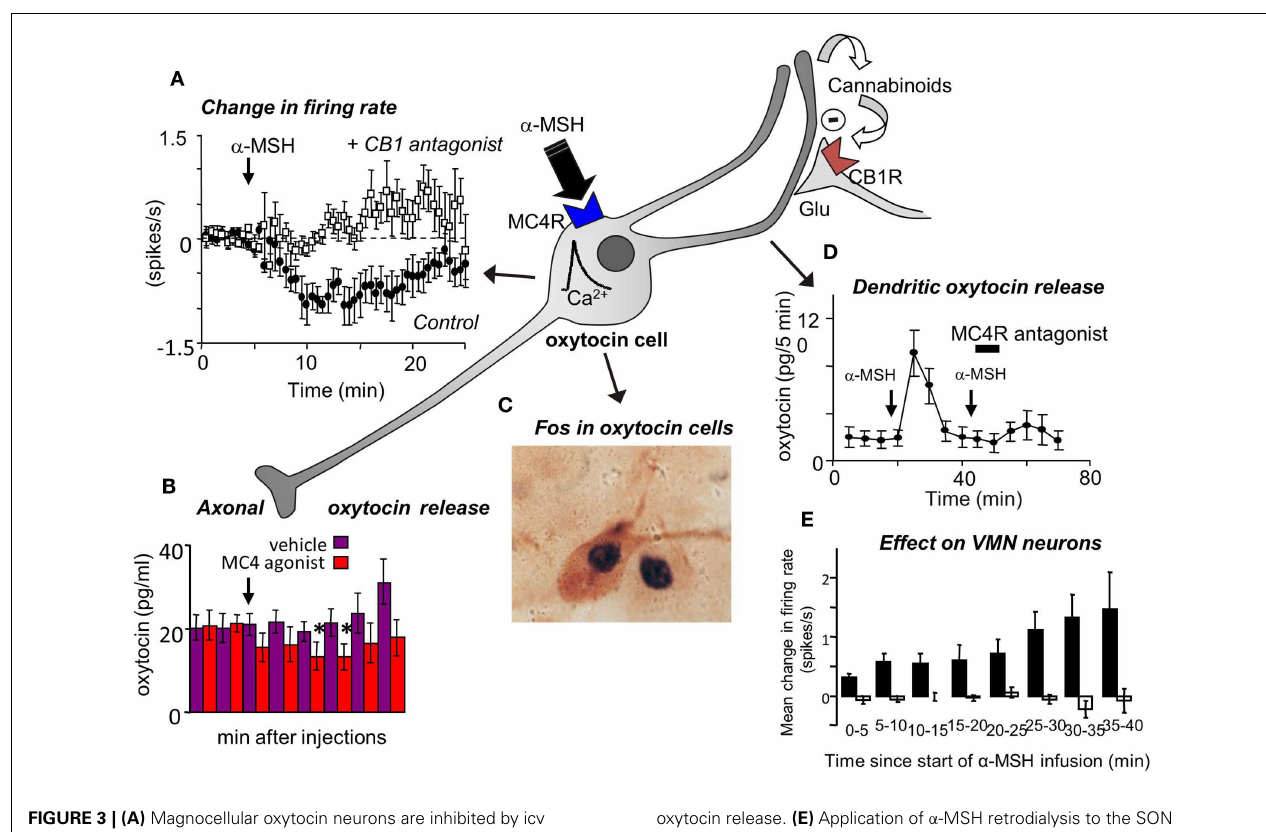
FIGURE 3 | (A) Magnocellular oxytocin neurons are inhibited by icv injections of α -MSH and this effect can be blocked by pre-administration of a CB1 cannabinoid antagonist (Sabatier et al., 2003). (B) Oxytocin secretion from the posterior pituitary gland is reduced by icv injection of MC4 agonists. (C) However, α -MSH and MC4 agonists induce Fos expression in magnocellular oxytocin neurons and (D) induce dendritic